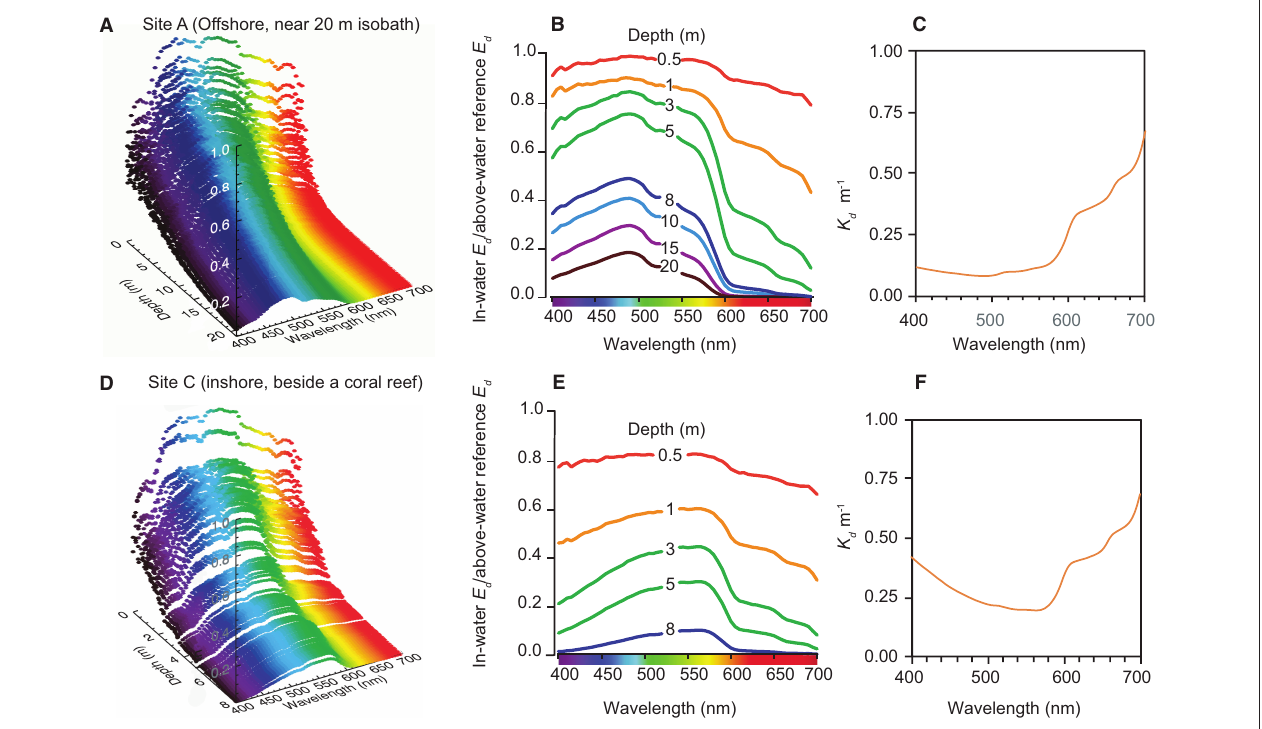
FIGURE 4 | Vertical light profiling study with the hyper-spectral radiometer for site (A) (furthest offshore) and site (C) (off Geoffrey Bay) (see Figure 1 ) in September 2016, showing: (A,D) 3D spectral profiles of W/m 2 /nm according to depth and wavelength (B,E) normalised downwelling irradiance spectra and (C,F) vertically averaged spectral attenuation coefficients K d .